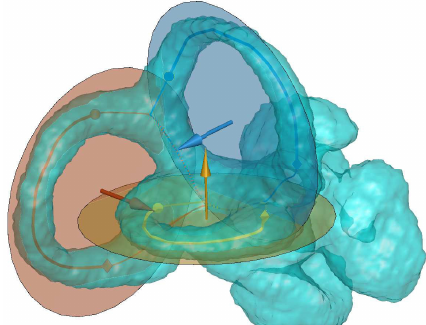
Figure 7. Transparent 3D reconstruction of SCs ducts. The solid sphere and diamond represent the beginning and the end of the retained part (continuous thick line) of the original trajectory (thin line) for determining the fitting plane. Each transparent circle represents the fitted plane to each one of the canals. The arrows correspond to the normal vector of each plane. The color encoding is yellow for the horizontal, blue for the anterior and red for the posterior